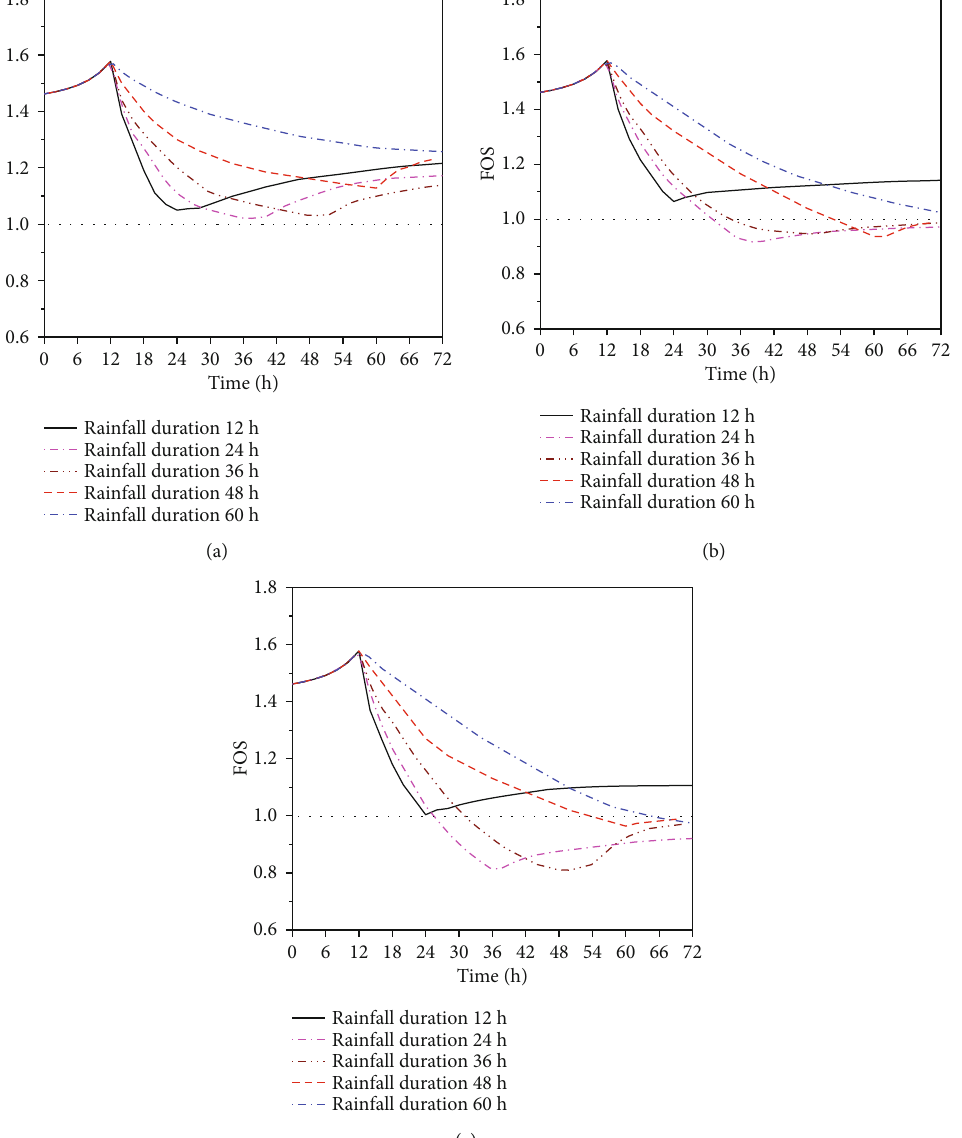
Figure 7: The FOS of uniform roots slope with the depth of 1.5m with di ff erent rainfall durations: (a) 400mm, (b) 500 mm, and (c)